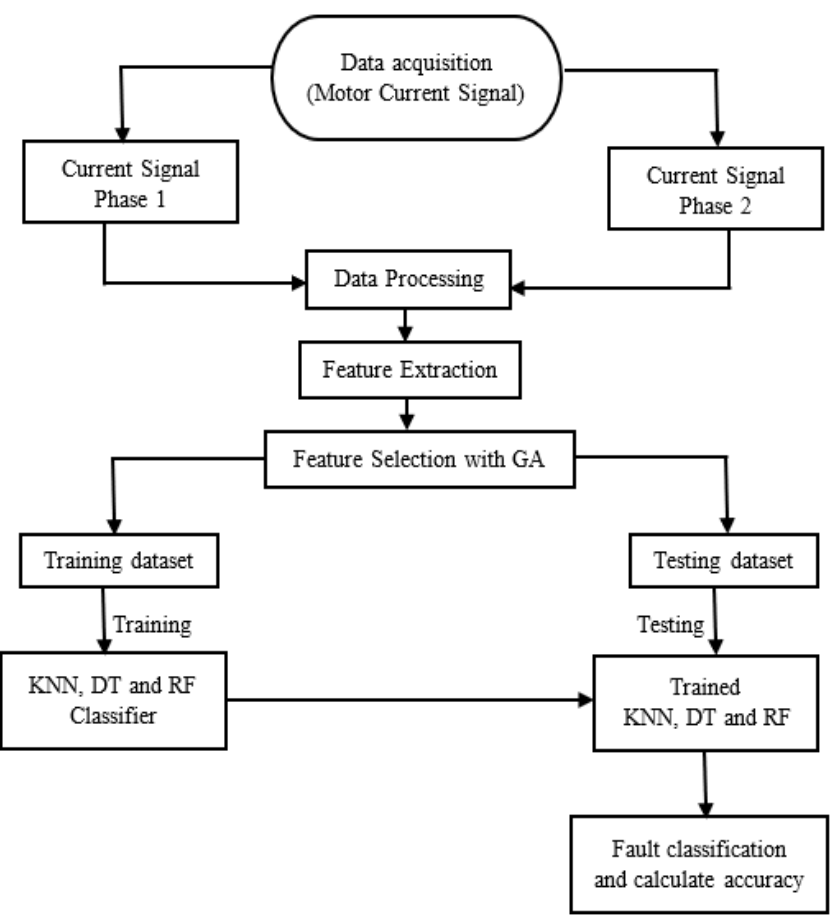
Figure 8. Schematic diagram of the proposed methodology.